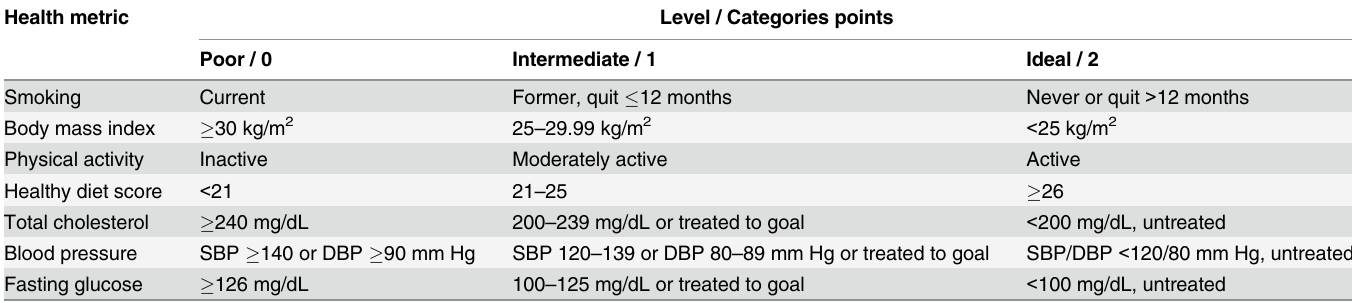
Table 1. Cardiovascular health — definition * and categories points.